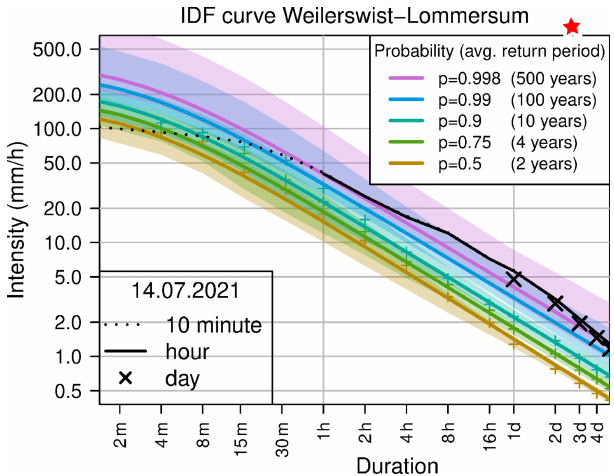
Figure 2. IDF curve for the weather station Weilerswist- Lommersum. Observations of 14 July precipitation are added in black based on different measurement intervals. Coloured lines de- pict different non-exceedance probabilities; respective shadings in- dicate 90% confidence